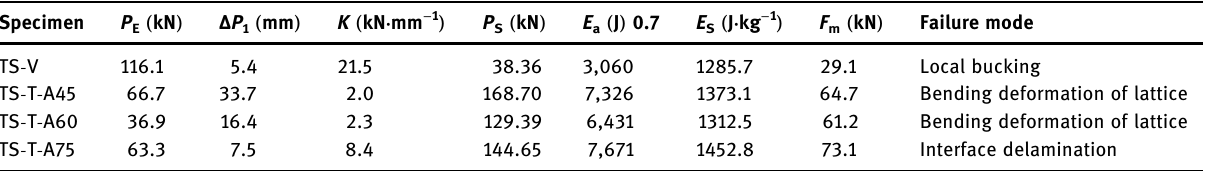
Table 4: Mean experimental results Specimen